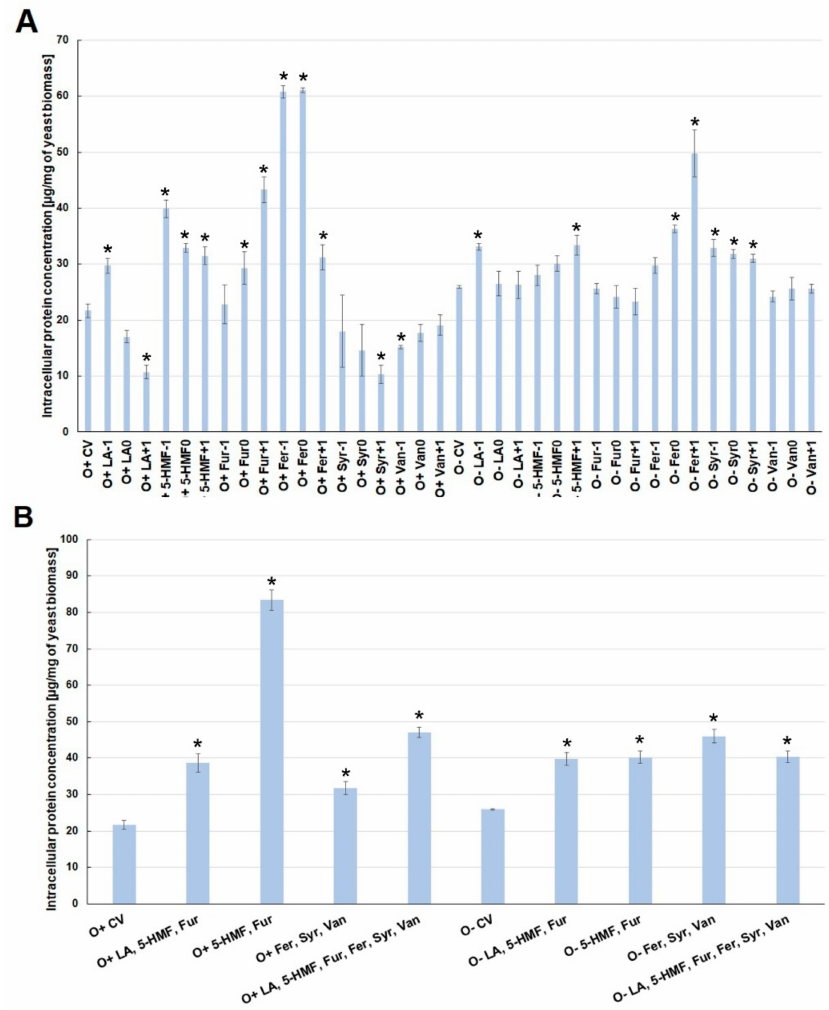
Figure 3. Effect of lignocellulose pretreatment by-products ( A , B ) on the production of intracellular proteins by yeast (*—statistically different from the corresponding control variant α <